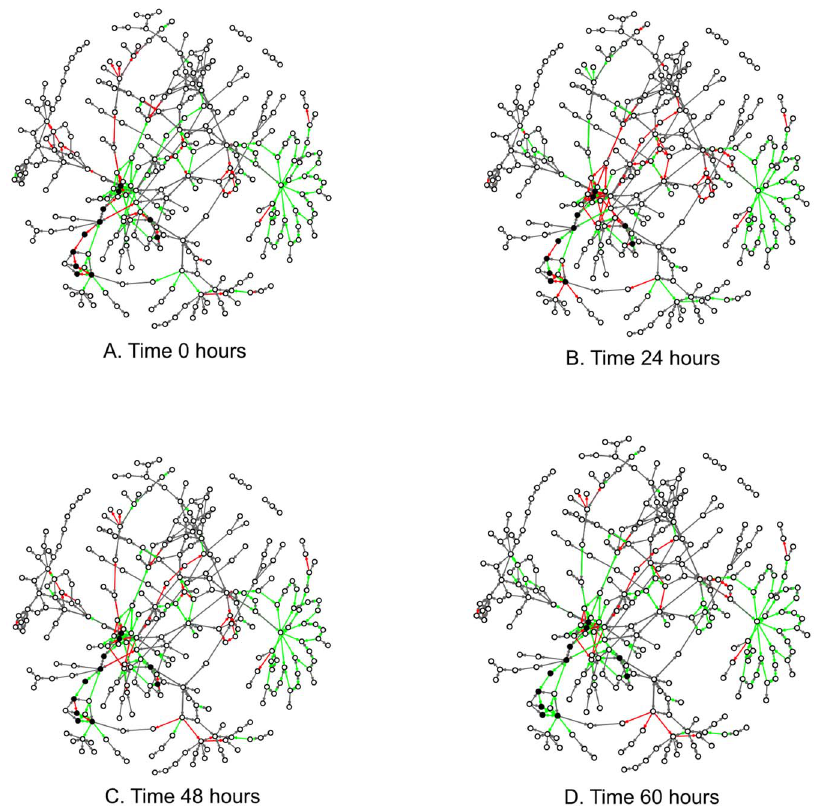
Figure 4. These graphs highlight the fold change direction of known genes in our data in response to oil accumulating conditions at each time point. A gene involved in a reaction is represented by an edge while the compounds in a reaction are represented by the nodes. Genes that were up-regulated during oil accumulation are drawn as green edges while red edges represent genes that were down-regulated. Genes for which data was unknown were drawn as gray edges. The compounds colored in black are part of the first shortest path found between glucose and triacylglycerol (Figure 2). The edges that connect those compounds shift from red to green during the 60 hour course of the experiment.